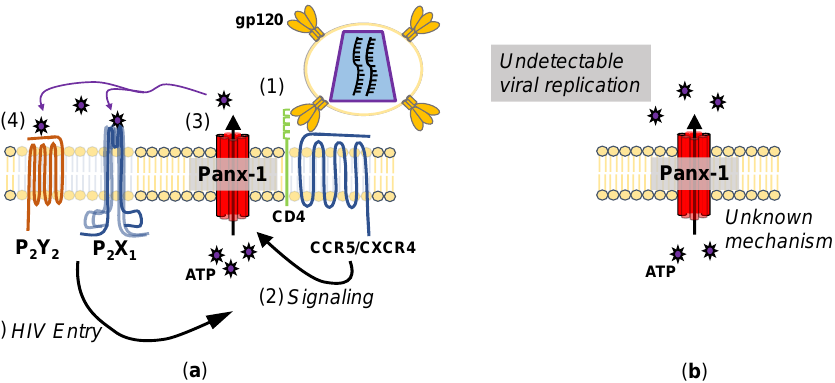
Figure 1. Mechanisms of Panx-1 opening during HIV infection. ( a ) Mechanism of Panx-1 opening during acute infection. (1) Upon binding to CD4 and CCR5 (or CXCR4), (2) signaling through this binding leads to Panx-1 becoming open, (3) releasing ATP. (4) The ATP released then binds to purinergic receptors, (5) allowing HIV entry. Inhibition of Panx-1 ATP release or P2 receptors inhibits HIV entry. ( b ) Mechanisms of Panx-1 opening during chronic infection. Peripheral blood mononuclear cells (PBMCs) isolated from HIV-infected patients show Panx-1 in a spontaneously open state, despite a lack of viral replication, but the mechanism is unknown.